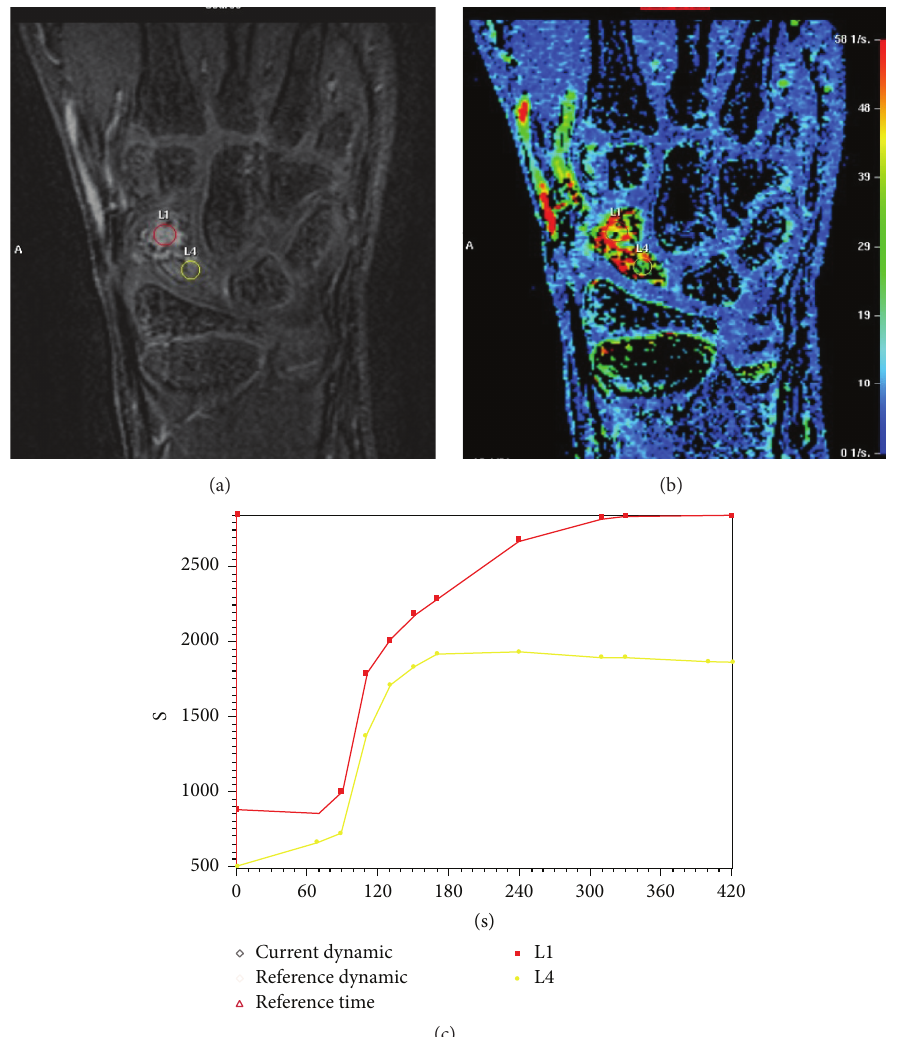
Figure 2: To assess the vascularity with dynamic contrast-enhanced MRI, a region of interest was placed on the proximal and distal scaphoid poles and time-signal intensity curves were recorded. The dynamic contrast-enhanced MRI showed fair perfusion of the proximal pole with account of measuring associated fibroblasts in the cystic alteration in the distal pole. The time-signal intensity curve on the proximal pole (yellow curve) was lower than the distal pole (red curve) with a maximum enhancement of